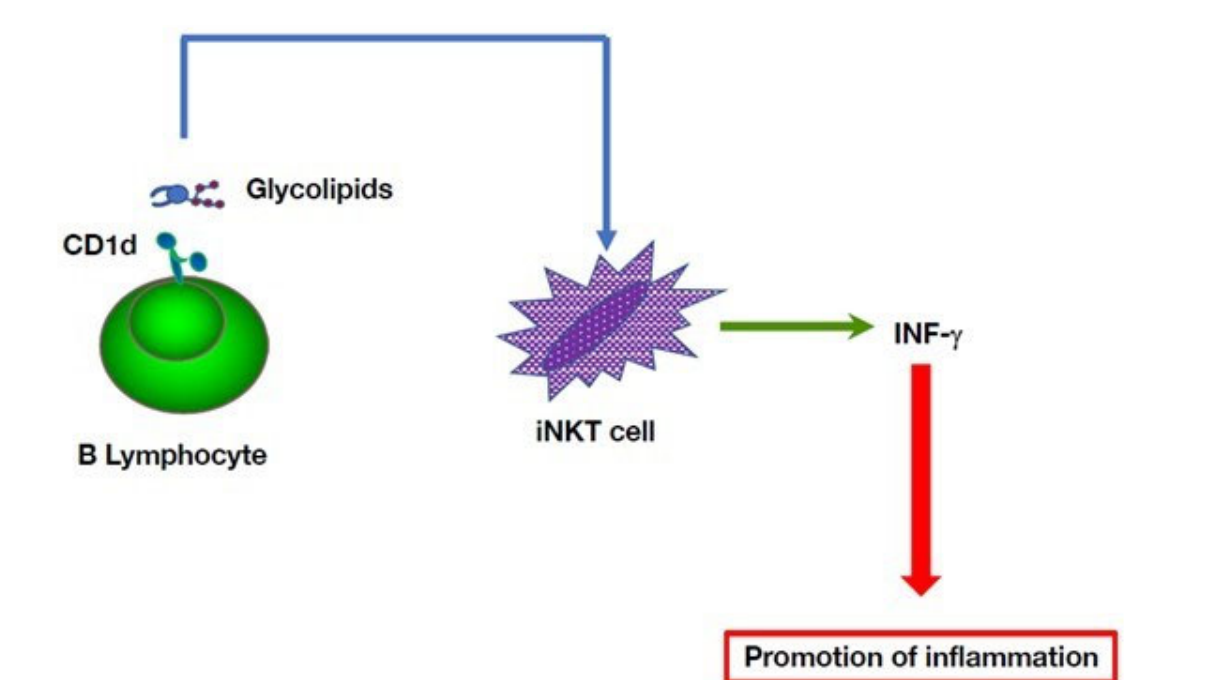
Figure 3. B cells produce cytokines that can mitigate various pro-inflammatory pathways. Anti- inflammatory activities of B cells that act on cells of the innate immune system have been well documented. Thus, human B cells can exert multiple immune suppressive activities on cells of both the adaptive and innate immune systems. They can inhibit CD8+ T cell-mediated cytotoxicity and suppress Th1 and Th17 inflammatory responses. In parallel, they also promote the differentiation of CD4+ T cells into IL-10+ T regulatory-1 (Tr1) cells and FoxP3+ Tregs cells. In addition to impacting adaptive immune responses, B cells reduce TNF- α production by monocytes, and reduce functions of iNKT cells.